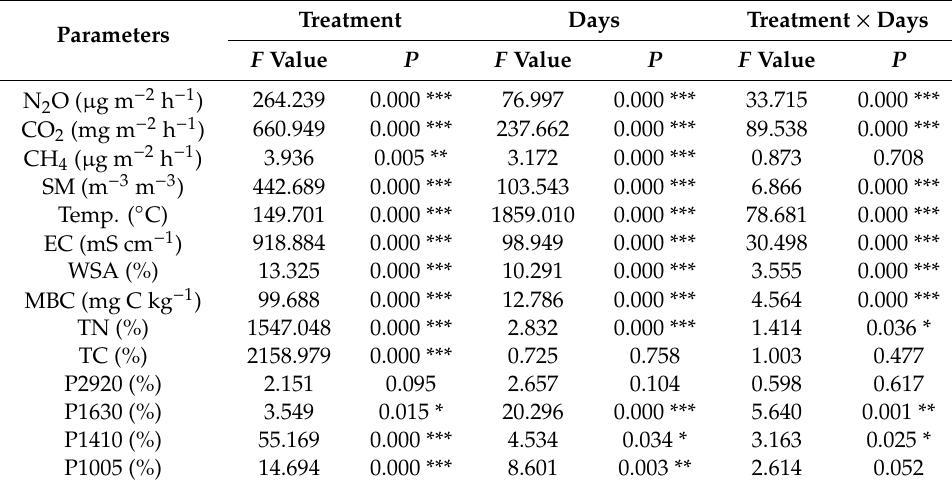
Table 3. Results of two-way ANOVA for the e ff ect of treatment, days, and the interaction of treatment by days for each parameter: soil moisture (SM), soil temperature (Temp.), electrical conductivity (EC), water-stable aggregates (WSA), microbial biomass carbon (MBC), total nitrogen (TN), and total carbon (TC); P1005: relative absorbance of the FTIR peak for silicates and clay minerals as well as C–O–C stretching in polysaccharides; P1410: relative absorbance of the FTIR peak for C–O bond vibrations and also the vibrations in C–N (amide III); P1630: relative absorbance of the FTIR peak for the aromatic C = C and C = O vibrations of amide I groups; P2920: relative absorbance of the FTIR peak for asymmetric C–H vibration of aliphatic compounds. Treatment Days Treatment × Parameters